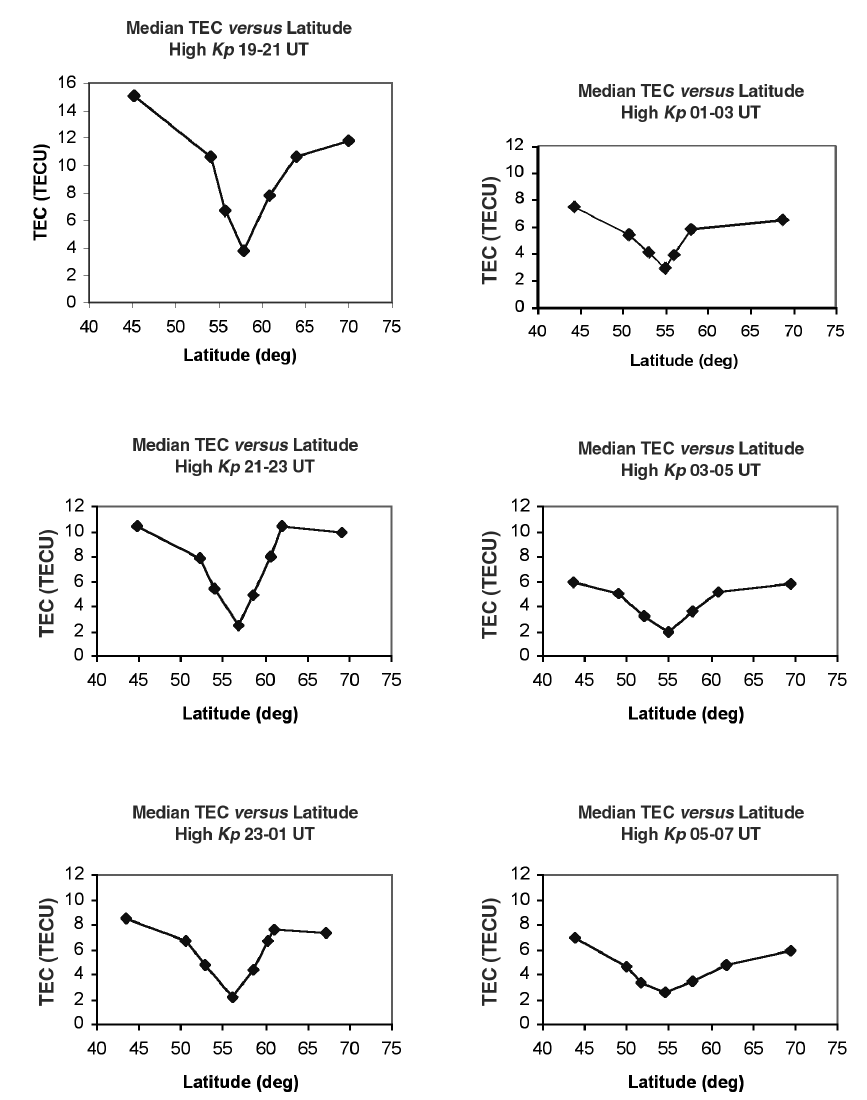
Fig. 8.8c. Median TEC versus latitude profiles of trough shape for successive two-hour bands throughout the night under disturbed geomagnetic conditions.